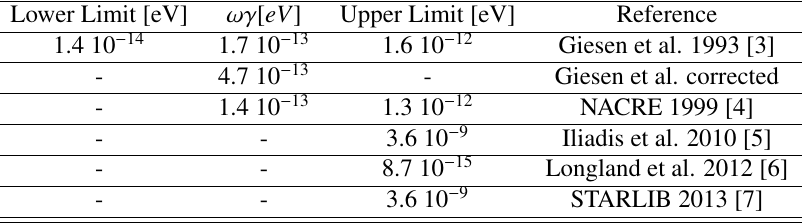
Table 1. Values of E α = 395 keV resonance strength reported in